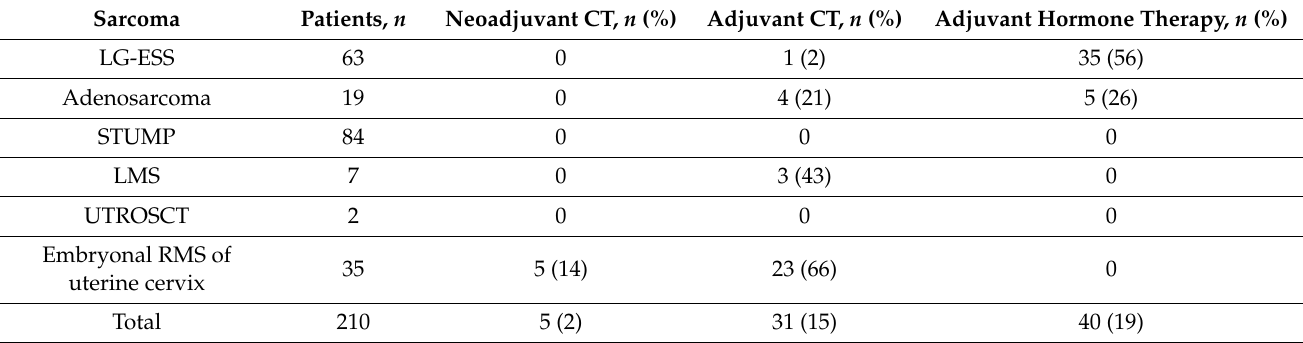
Table 10. Medical therapy in FST of uterine sarcomas.